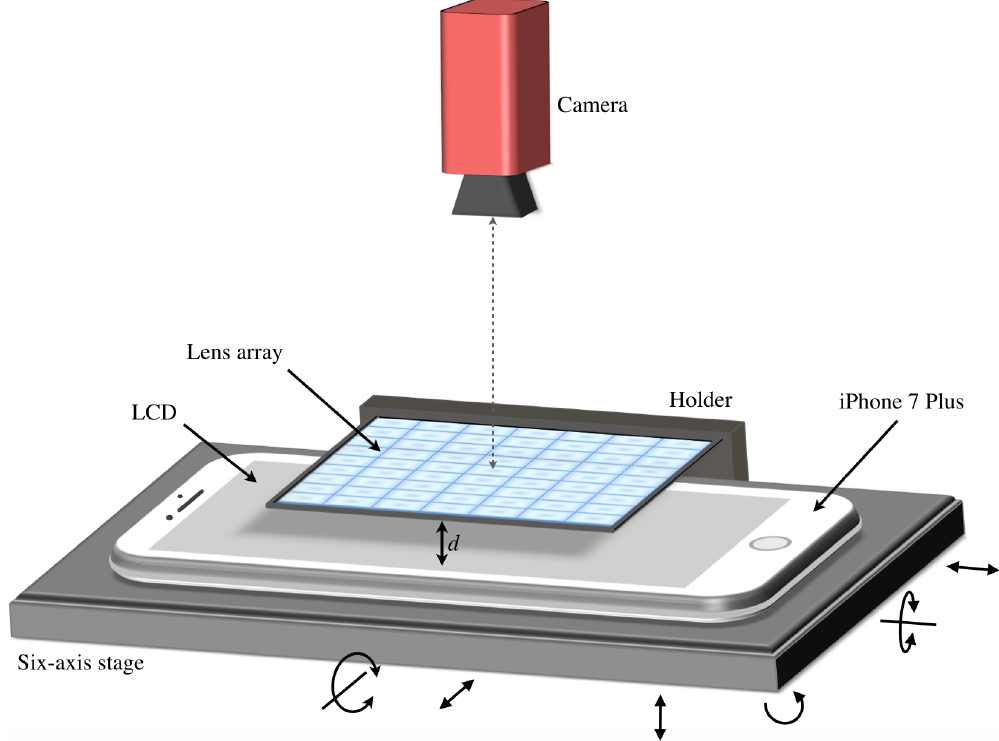
Figure 3. Optical components and configuration of the wave field synthesis 3D imaging system. The lens array is placed inside the holder in a vertical distance d to the LCD. The arrows indicate the movability of the six-axis stage. The depicted images can be captured by a camera placed vertically above the lens array.